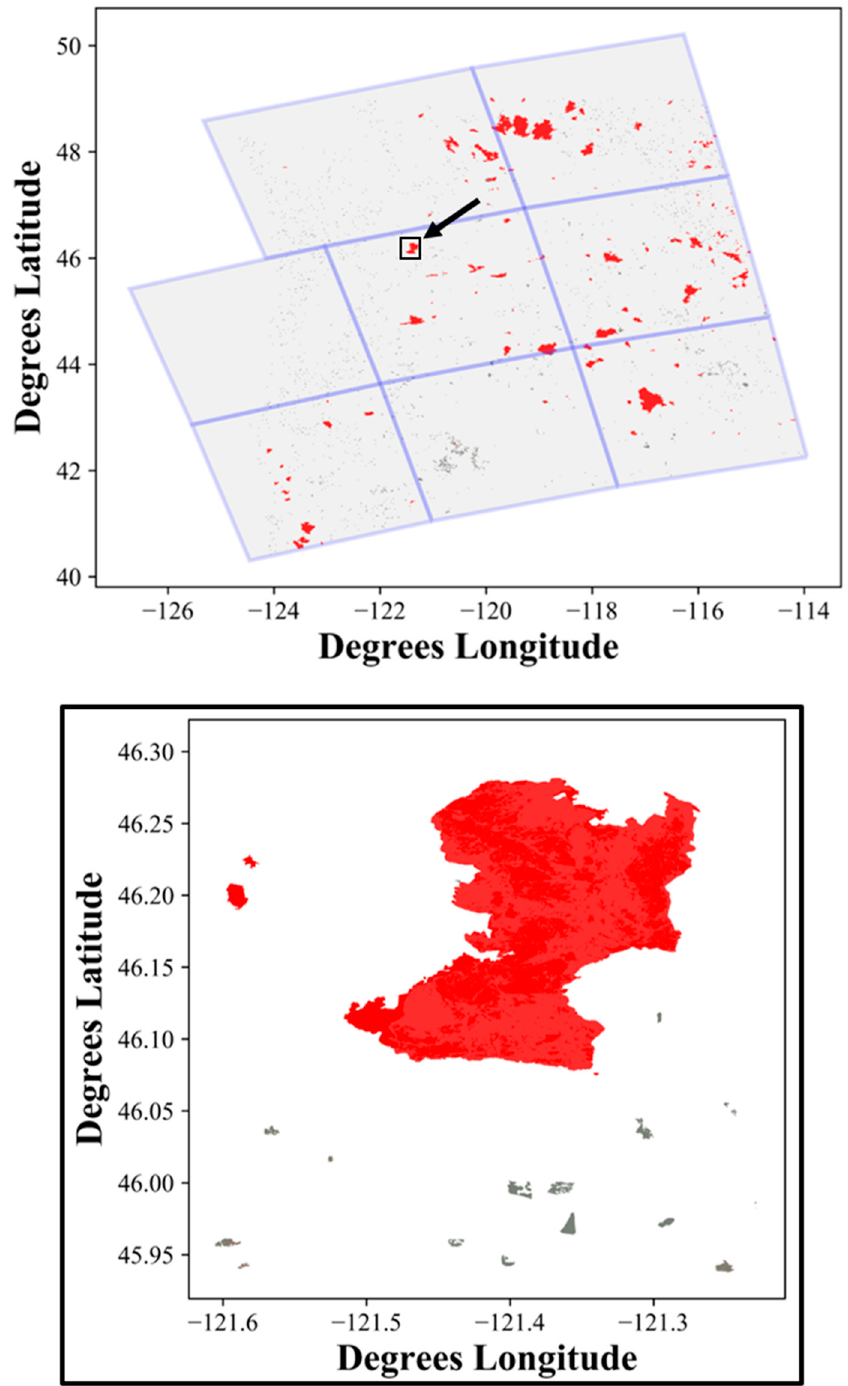
Figure 3. Map of 2015 disturbances overlain the Pacific Northwest (blue outline) prototype area (top image), where the black arrow highlights the location of the inset map (bottom image). Red indicates changes caused by fire and gray indicates clear-cut areas.